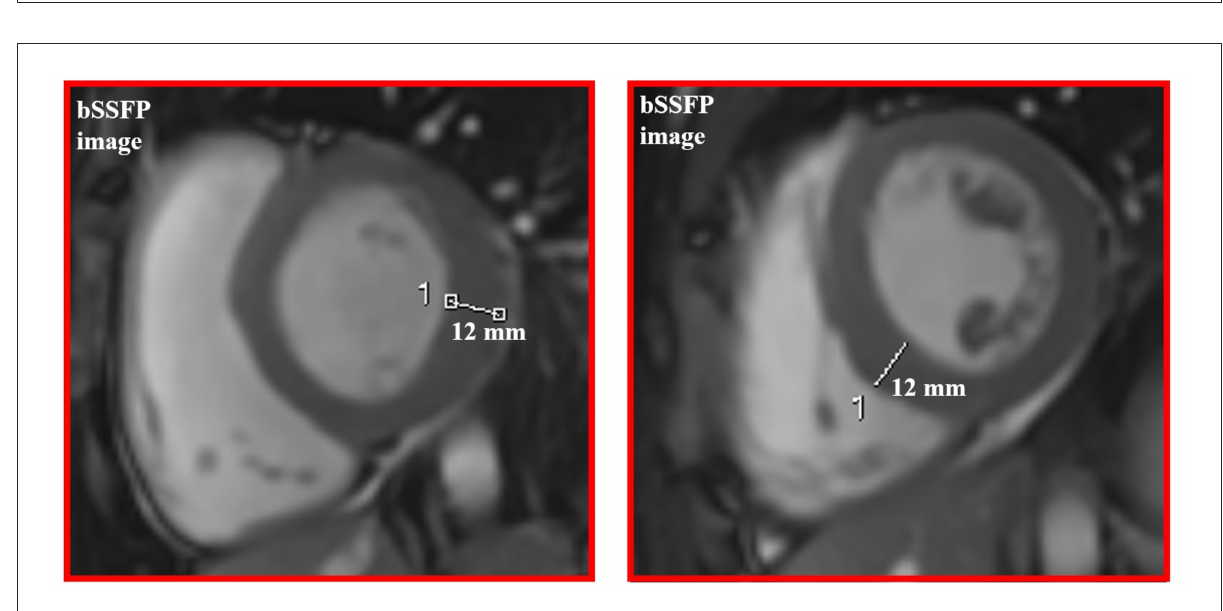
FIGURE2 Concentric left ventricular hypertrophy of basal and mid segments on cine images.